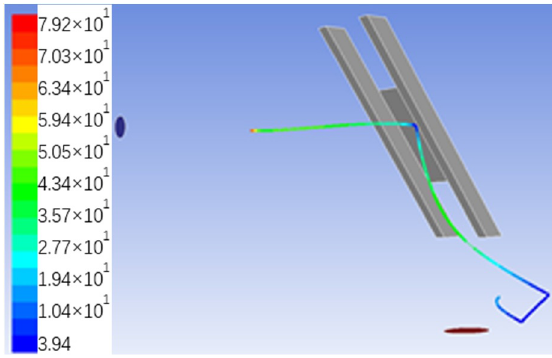
Figure 15. Pressure distribution of a single stone grain.